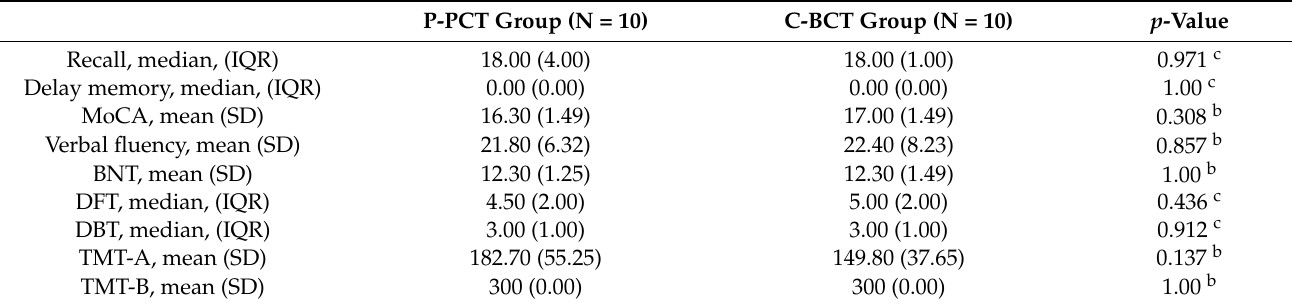
Table 2. Neuropsychological test scores of the groups at